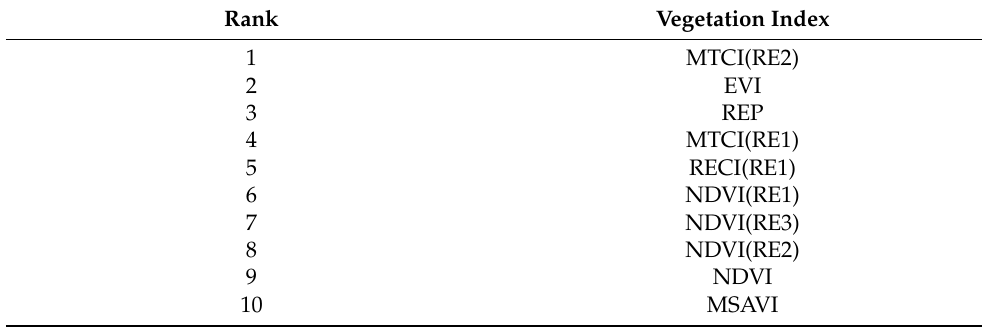
Table 5. Optimal VIs for field estimation during the whole growth period.